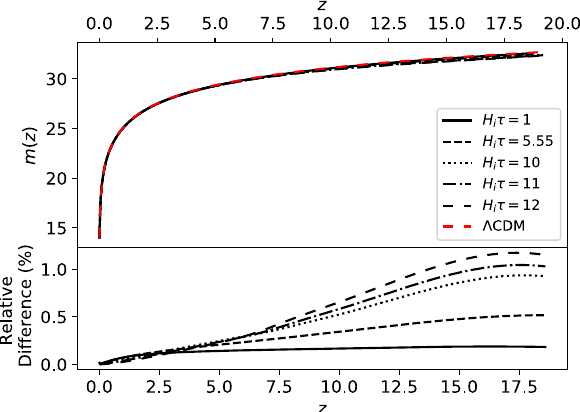
Fig. 5 The evolution of the Hubble expansion rate H ( z ) in units of km s − 1 Mpc − 1 . Shown on the bottom plot is the relative difference between time-delayed cosmology and Λ CDM, which is used as the reference. The predictions have been normalized to have the value of the Planck 2018 estimate of the Hubble constant H 0 at z = 0. A striking feature of time-delayed cosmology is a kink or a point at which its prediction changes sharply. These kinks are encircled in blue